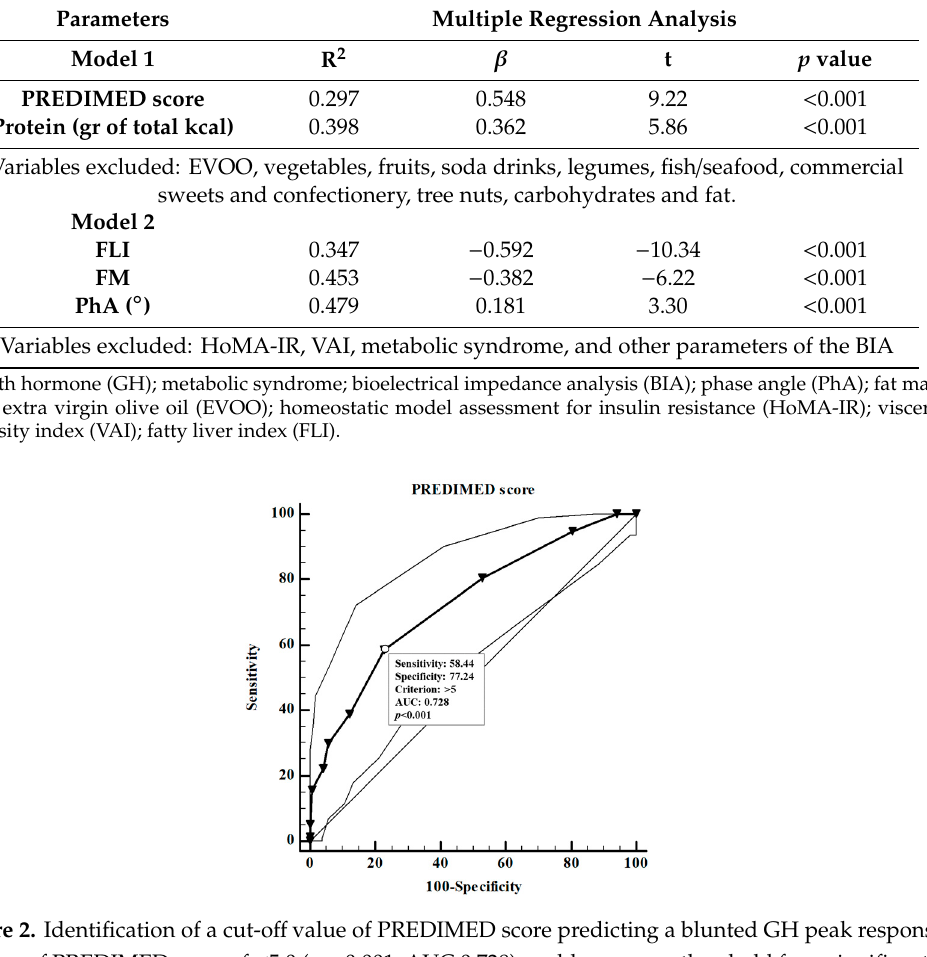
Figure 2. Identification of a cut-off value of PREDIMED score predicting a blunted GH peak response. A value of PREDIMED score of ≤ 5.0 ( p < 0.001, AUC 0.728) could serve as a threshold for a significantly decrease of GH peak response. A p value in bold type denotes a significant difference ( p < 0.05). Growth hormone (GH); area under the curve